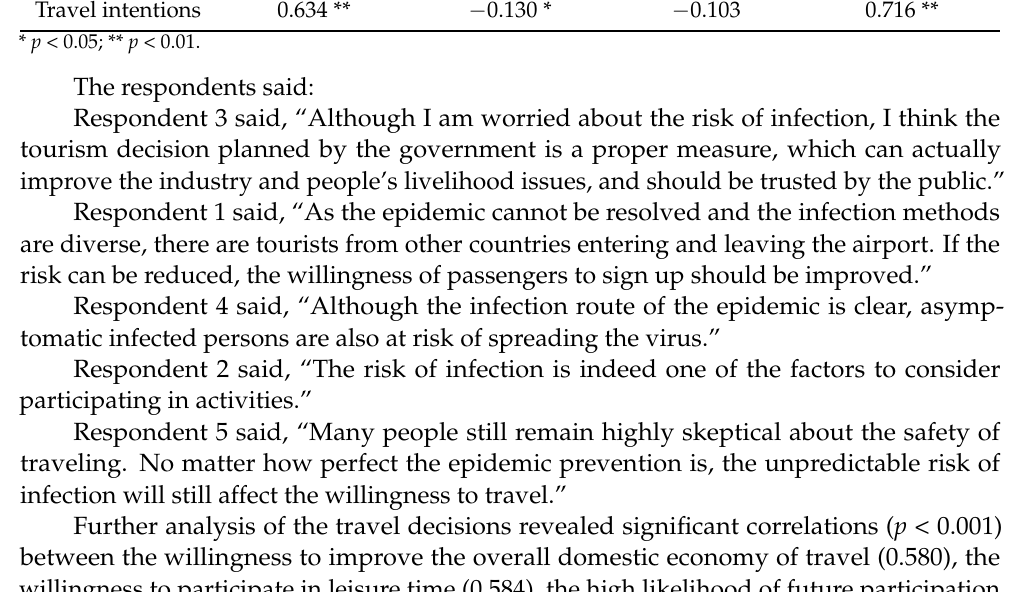
Table 4. Correlation analysis of travel decisions, risk perception, health beliefs, physical and mental health, and travel intentions. Physical and Environmental Health Beliefs Facet Travel Decision Mental Health Risk Travel intentions 0.634 ** − 0.130 * − 0.103 0.716